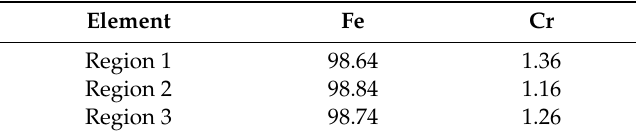
Table 3. EDS analysis results of the banded structure of the SZ in the repaired sample (regions 1–3 are the region marked in Figure 7h) (wt %).